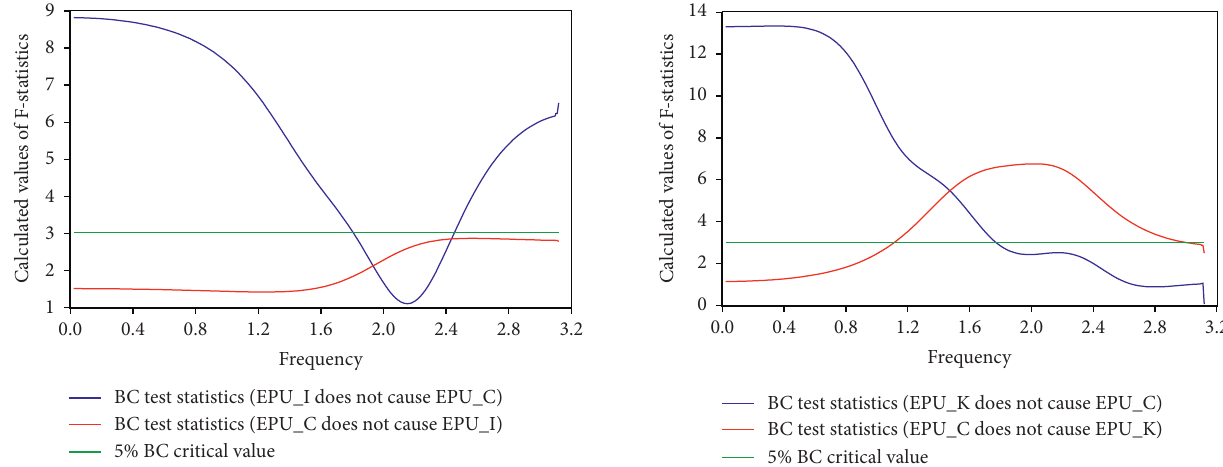
Figure 4: The frequency domain causality between China’s and Korea’s EPU indices. The part of the lines above the critical value- line indicates rejection of the null hypothesis of no Granger causality.